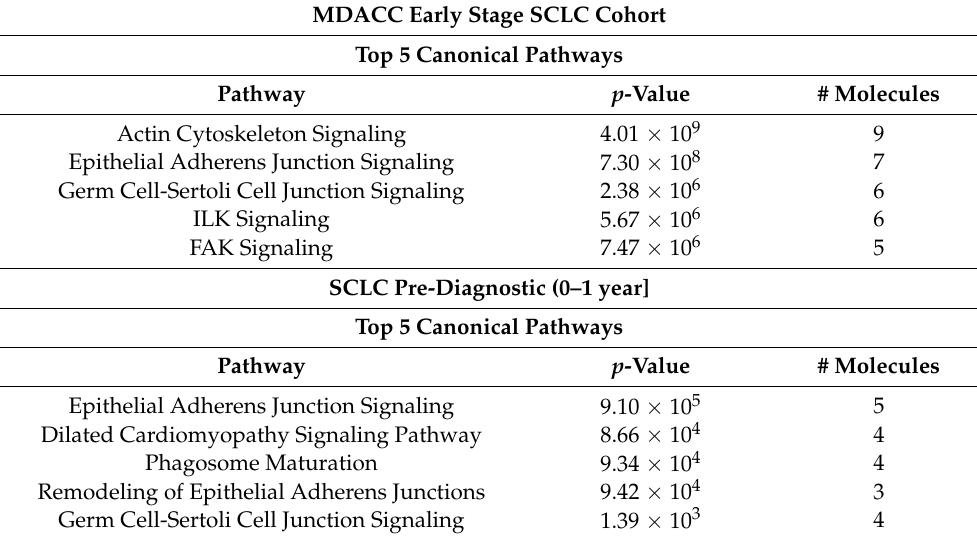
Table A3. IPA analyses on YAP1-associated proteins that were elevated (AUC ≥ 0.60) in case plasmas collected at the time of diagnosis or within one-year preceding diagnosis of SCLC.